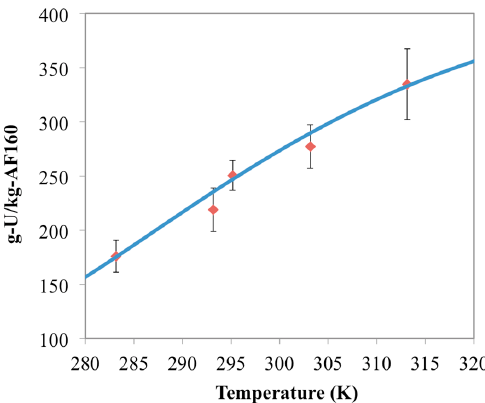
Figure 2. Comparison between optimized chemisorption model results (blue line) and the AF160 experimental data (red diamonds) collected in this study. Error bars represent two standard deviations of the data.